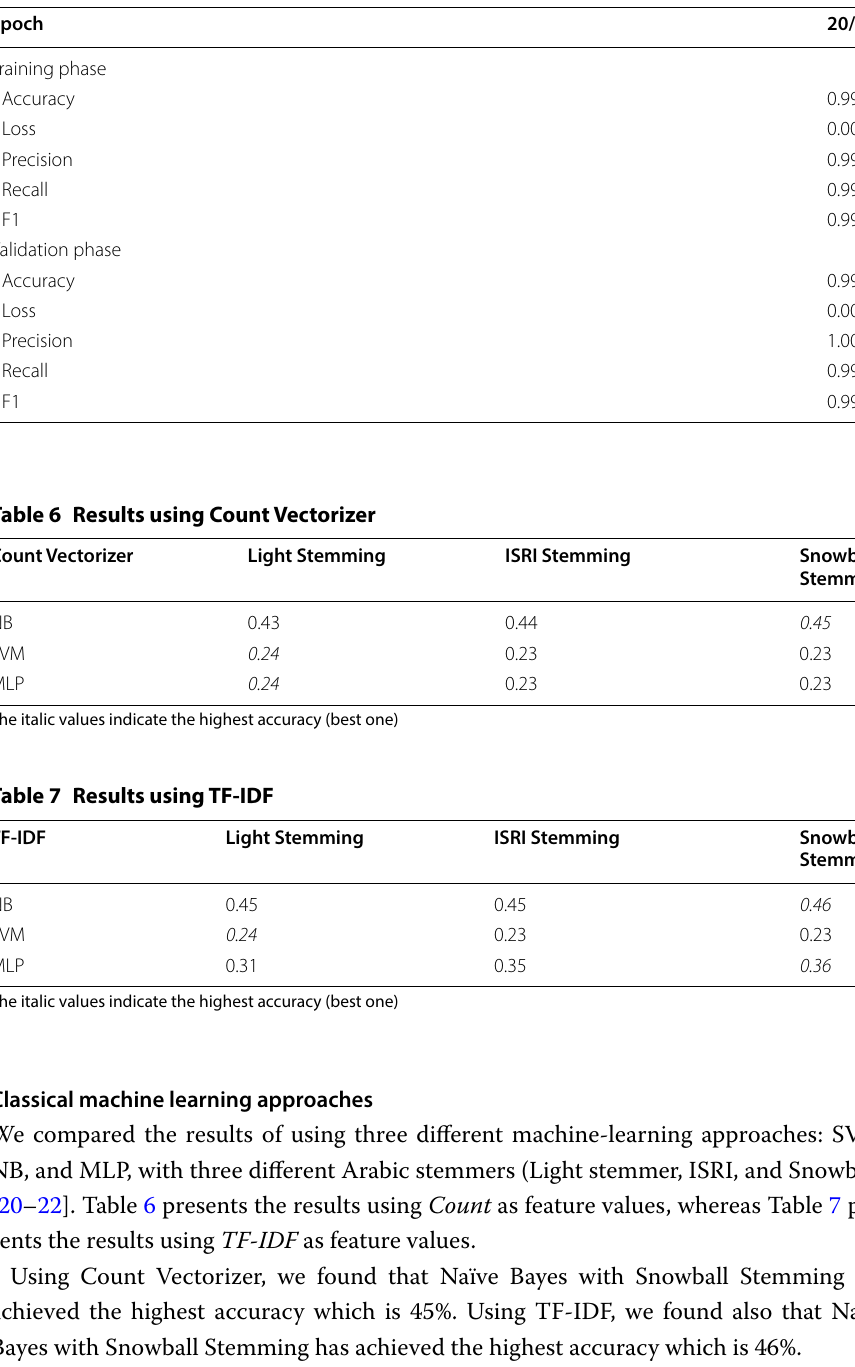
Table 5 Summary of the results (last epoch)